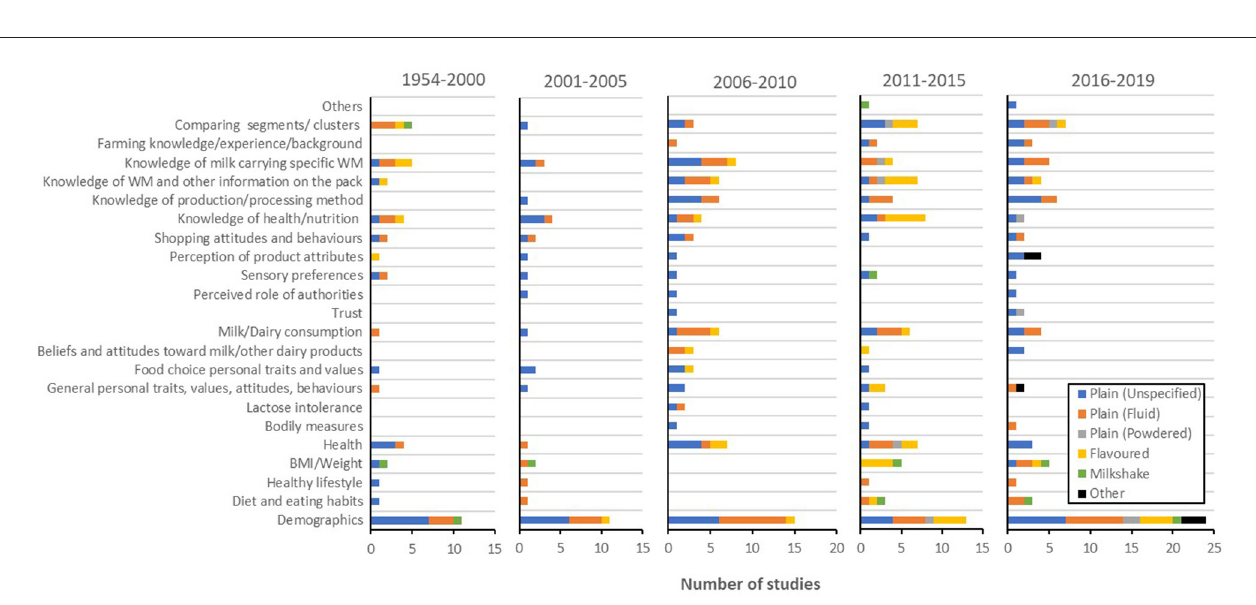
FIGURE 11 | Prevalence of receiver-related empirical studies for each milk type [i.e., plain (unspecified), plain (fluid), plain (powdered), flavoured milk, milkshake, and other milk drinks] during each period (i.e., 1954–2000, 2001–2005, 2006–2010, 2011–2015, and 2016–2019). WM, well-being messaging; BMI, body mass